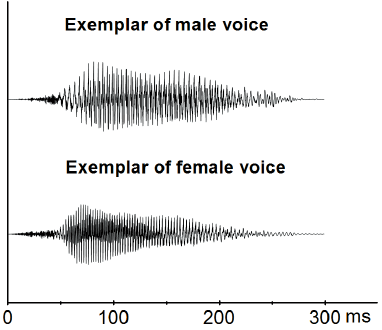
Figure 1. Sound waveforms. Two representative exemplars of the 9 male voices and 9 female voices were illustrated. The consonant part (/ h-/) of the sound was normalized at around 40 ms in duration and the whole sound was normalized at 300 ms in